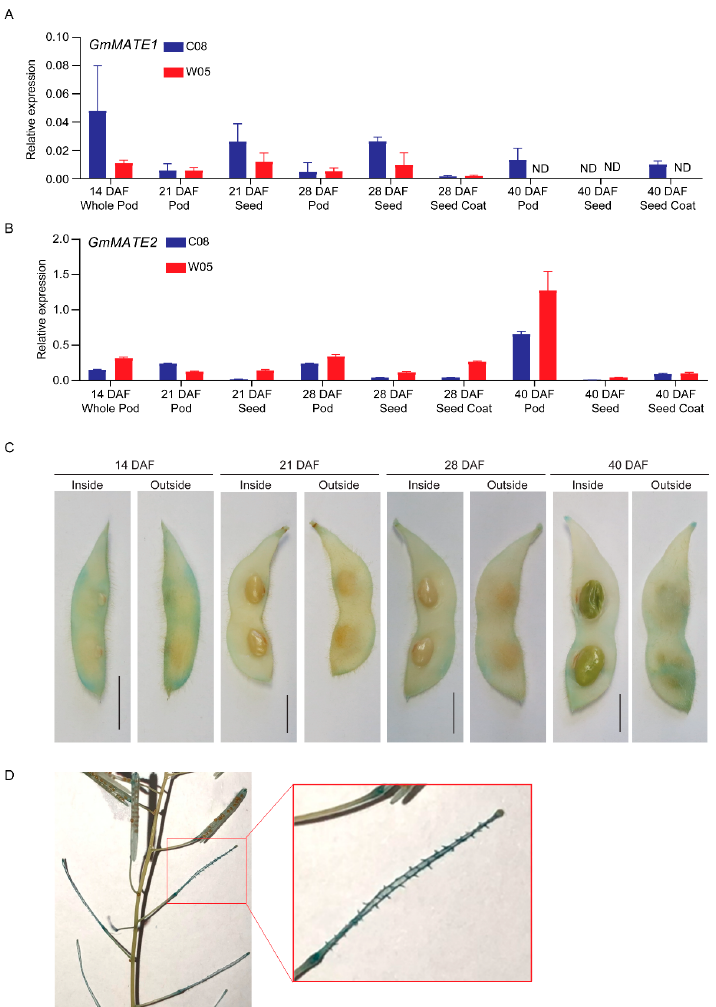
Figure 4. Relative expressions of GmMATE1 and GmMATE2 in different tissues within the develop- ing soybean seed pod. The relative expression of ( A ) GmMATE1 and ( B ) GmMATE2 in different tissues of the developing pod, normalized to the reference gene, VPS , using the 2 - Δ Ct method. DAF, days after flowering. Values shown are the averages of three technical replicates ± SEM. Similar expression trends were obtained in another biological repeat. ( C , D ) Photos showing the GUS stain- ing of ( C ) transgenic soybean pods and ( D ) transgenic A. thaliana expressing β -glucuronidase (GUS) driven by the native GmMATE1 C08 promoter. Similar results were obtained from two independent transgenic lines. Scale bar = 1 cm.